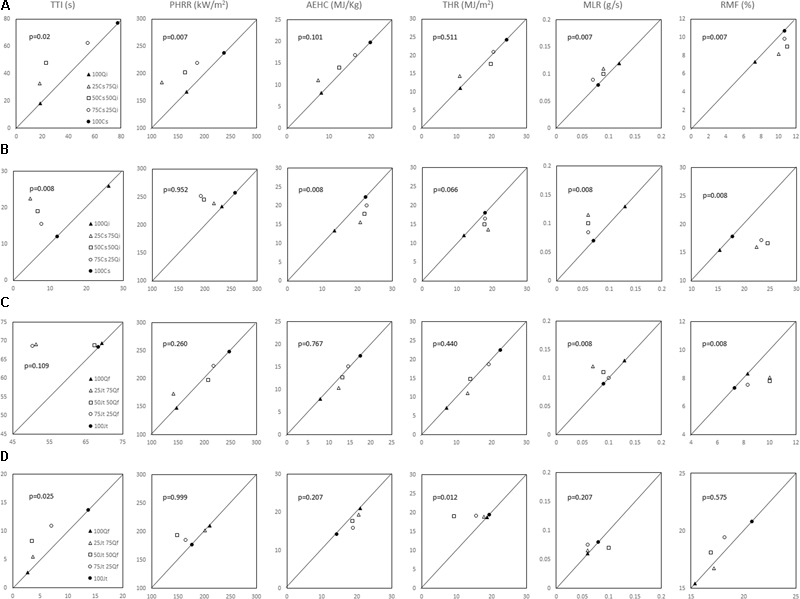
Observed versus expected values for the flammability parameters considered for both live foliage and litter mixtures were evaluated by Wilcoxon’s paired test. p-values are reported in each graph (A) live foliage of C. sempervirens–Q. ilex mixtures; (B) litter of C. sempervirens–Q. ilex mixtures; (C) live foliage of J. thurifera–Q. faginea mixtures; (D) litter in J. thurifera–Q. faginea mixtures. Cs, Cupressus sempervirens; Qi, Quercus ilex; Jt, Juniperus thurifera; Qf, Quercus faginea.